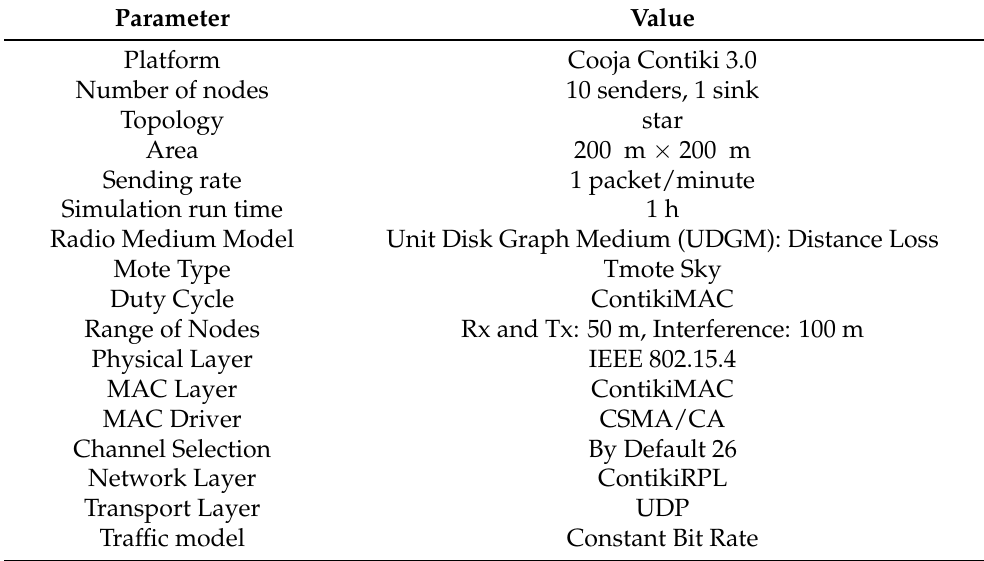
Figure 12. Simulation topology. Table 1. Simulation